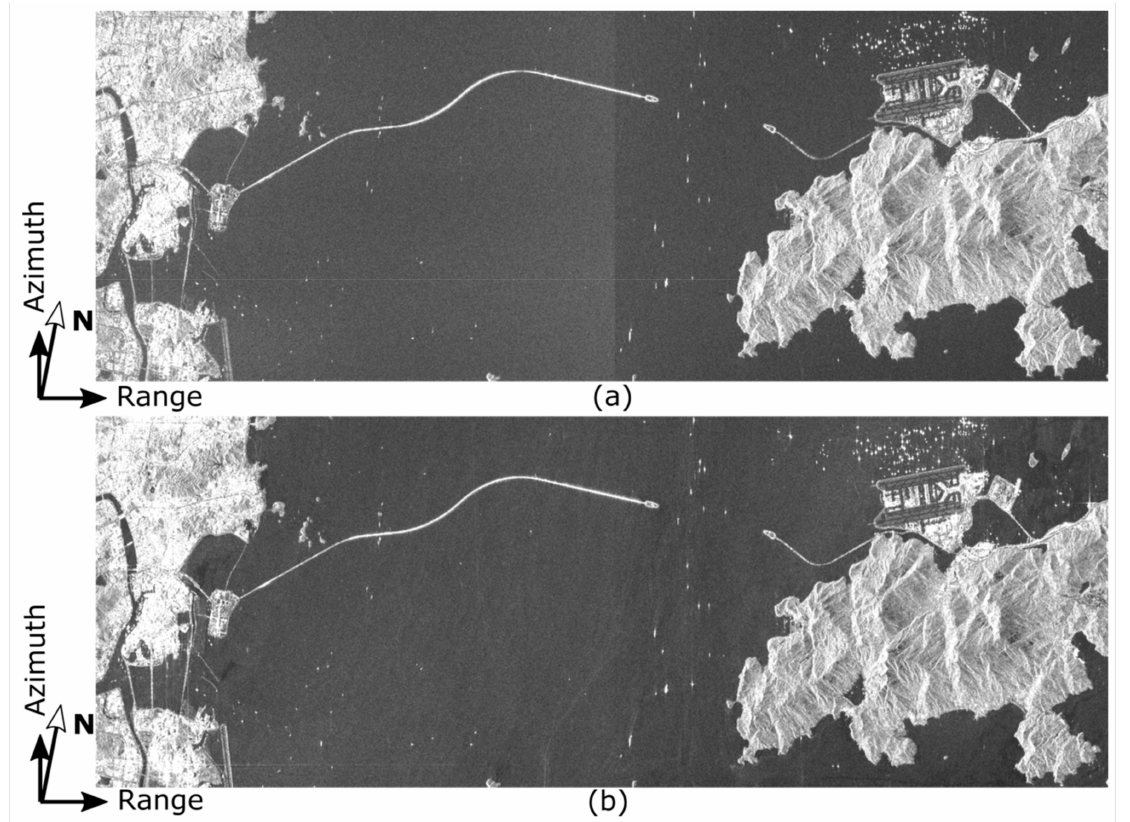
Figure 4. Amplitude images of ( a ) VH and ( b ) VV polarisations acquired on 30 May 2018 in the radar imaging geometry.